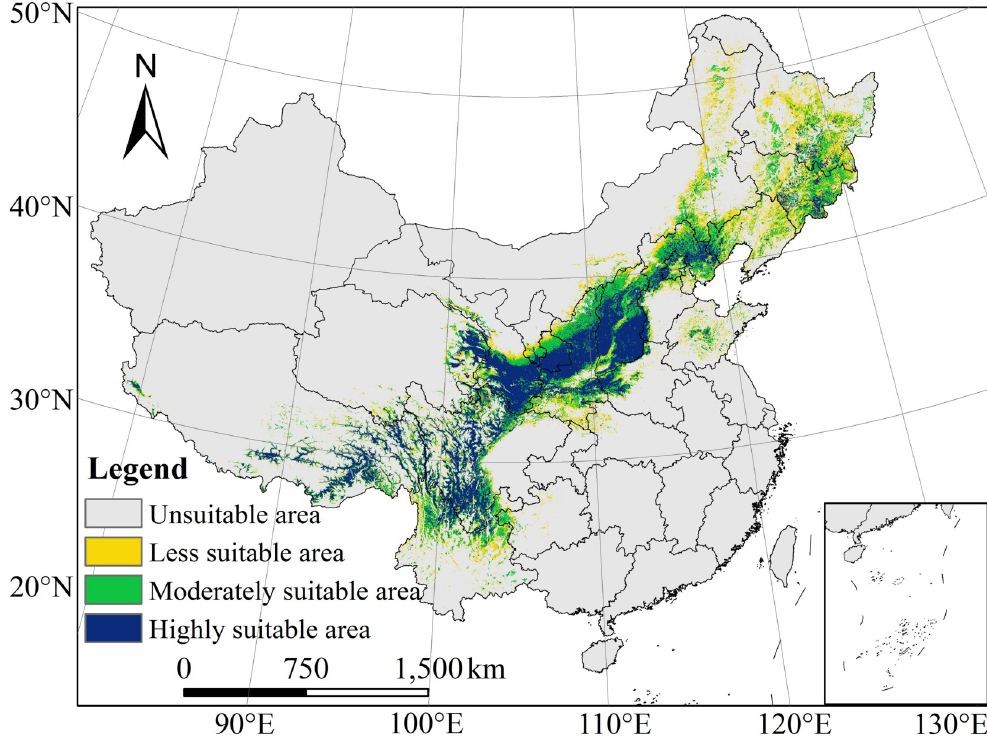
Fig 4. Distribution of suitable area for Betula platyphylla Suk. under current climate scenarios. (When presence probability is < 0.2932, unsuitable area; When presence probability is 0.2932–0.40, less suitable area; When presence probability is 0.40–0.60, moderately suitable area; And when presence probability is > 0.60, highly suitable area). The boundary was obtained from Natural Earth (http://www.naturalearthdata.com/). Based on the principle of national and territorial integrity, we have modified and adjusted the vector boundary.